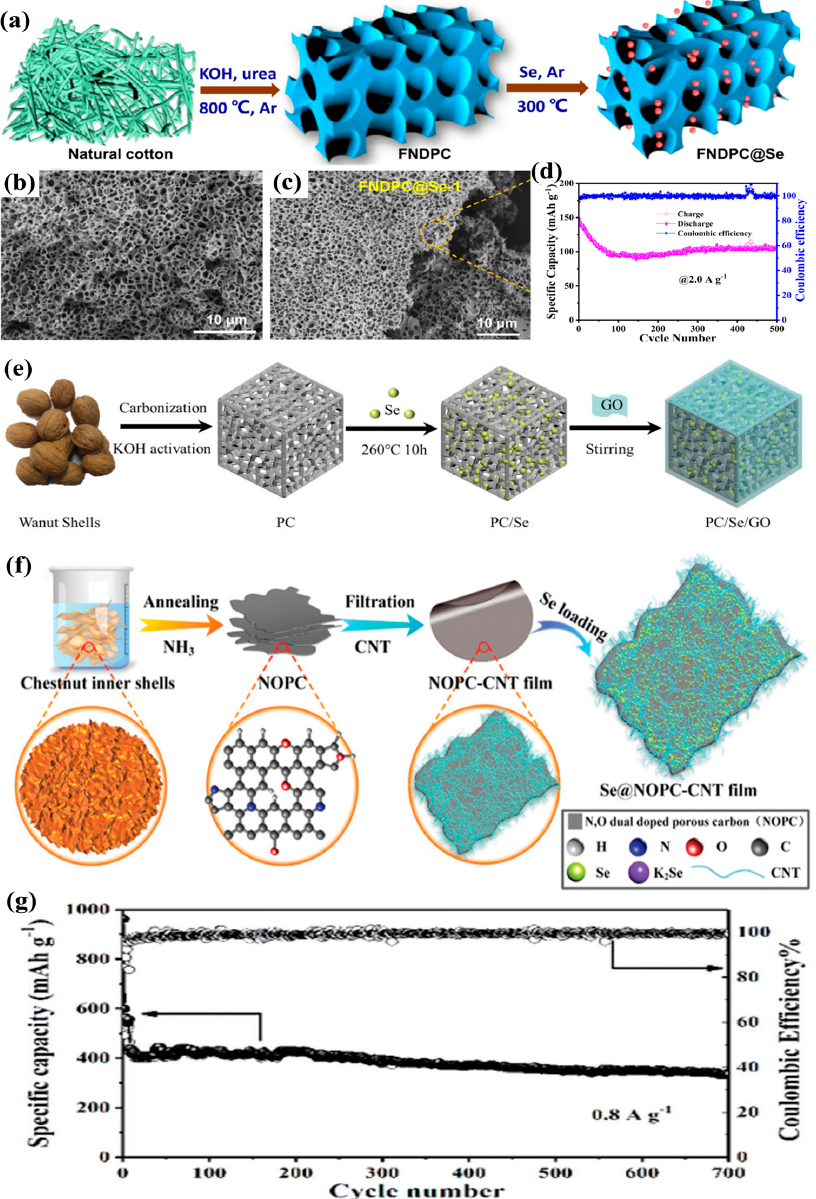
Figure 6. ( a ) Schematic illustration of the FNDPC@Se synthesis process, ( b ) SEM image of FNDPC, ( c ) SEM images of FNDPC@Se-1 composite. ( d ) Cycling performances at 2.0 A g − 1 , reproduced with